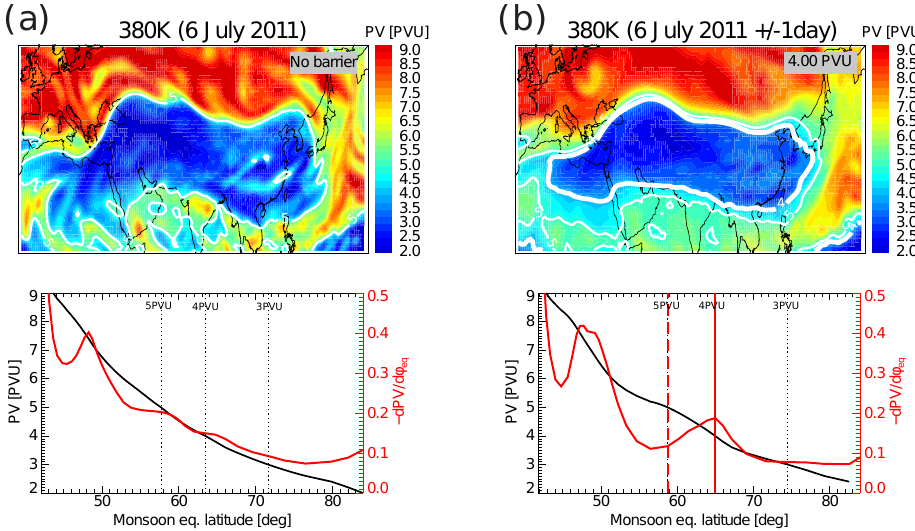
Figure 5. (a) Potential vorticity map at 380K on 6 July 2011, in the Asian monsoon region between 10–60 ◦ N and 10 ◦ W–160 ◦ E (upper panel), and PV as a function of the monsoon centered equivalent latitude (lower panel). Monsoon equivalent latitude φ eq is calculated from the area within PV contours (see text). Shown is PV( φ eq ) (black) together with the respective PV gradient ∂ PV /∂φ eq (red). Low PV and large φ eq indicate the anticyclone center. (b) Same as panel (a) but for the PV-field averaged between 5 and 7 July 2011. The anticyclone transport barrier, deduced from a local maximum in the PV gradient (see text), is shown as white thick contours (upper panels) and red solid vertical lines (lower panels), respectively. White thin contours (upper panels) and red dashed lines (lower panels) show 5PVU. Black dashed lines (lower panels) highlight particular PV values. The PV-value of the barrier is given in the grey box.